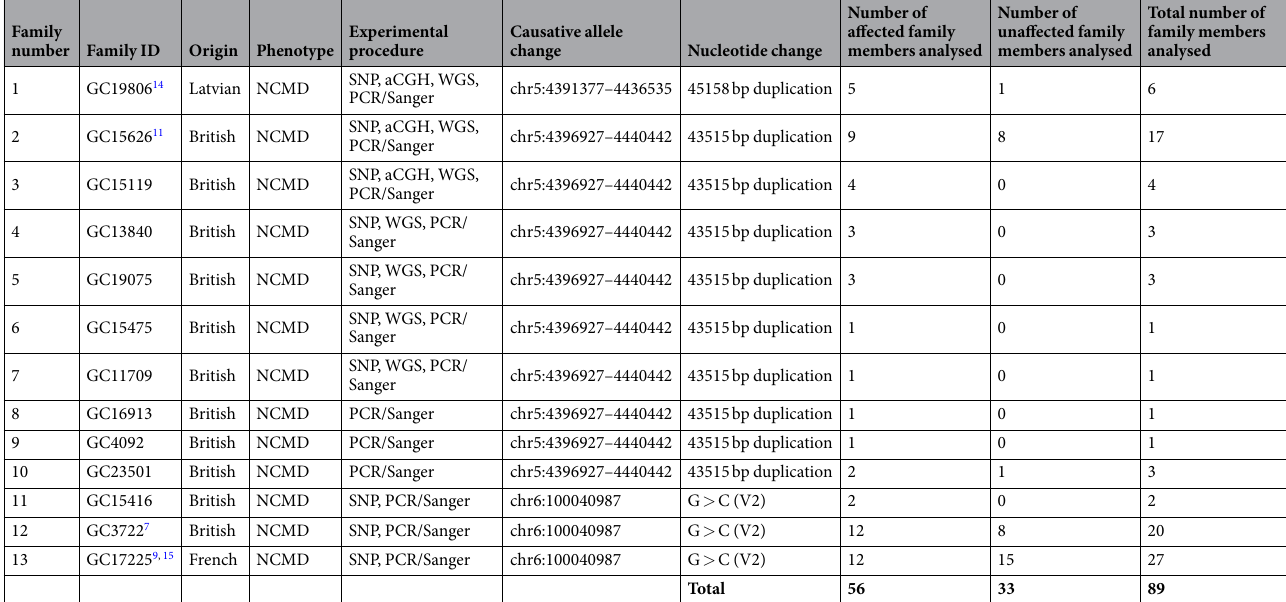
Table 1. Summary of families with two newly reported tandem duplications at the MCDR3 locus and previously identified V2 variant at the MCDR1 locus. Genomic coordinates refer to GRCh37/hg19 assembly. SNP, aCGH, WGS, PCR/Sanger indicate Illumina SNP array, array-based comparative genomic hybridization, whole-genome sequencing and Sanger Sequencing, respectively. Five affected members from five additional NCMD families were also tested for the presence of previously reported SNVs V1-V3 15 and the two tandem duplications found in this study, but none of these affected individuals was found to carry any of the